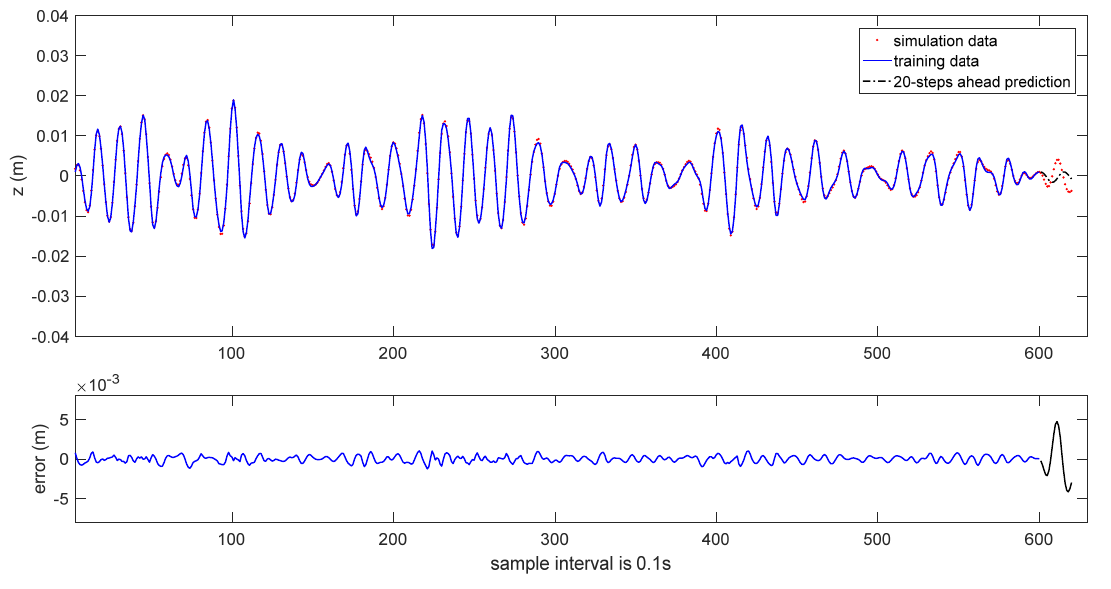
Figure 6. The 20-steps-ahead prediction of heave motion in irregular waves for the R-Class Icebreaker model.